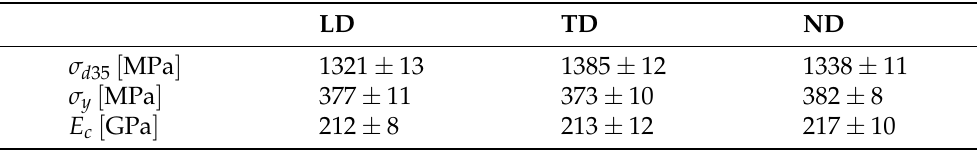
Table 5. Mechanical properties of WAAM-fabricated S355JR steel in LD, ND, and TD directions obtained by compression test results, shown in Figure 12. σ d 35 , σ y , and E c are strength at compressive strain of 35%, compressive yield strength and compressive Young’s modulus,